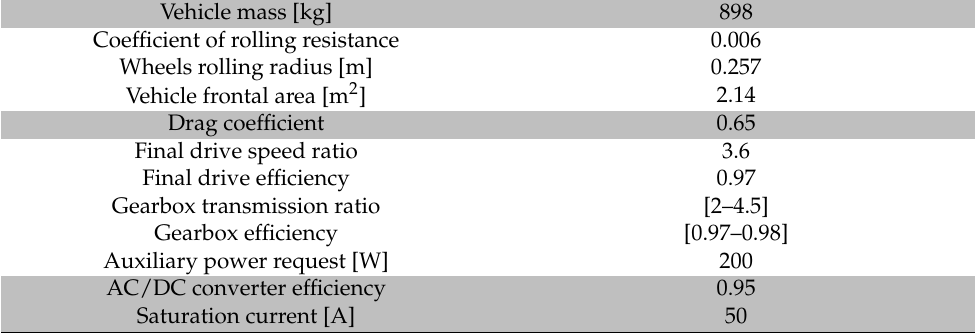
Table 3. Model parameters.